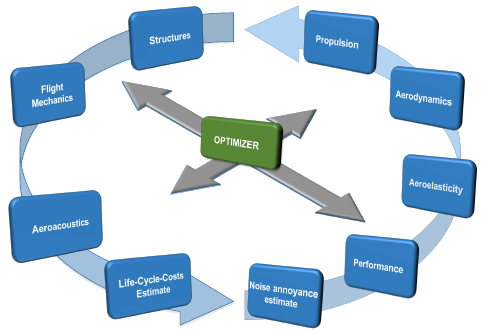
Figure 3: Analysis modules present in FRIDA.